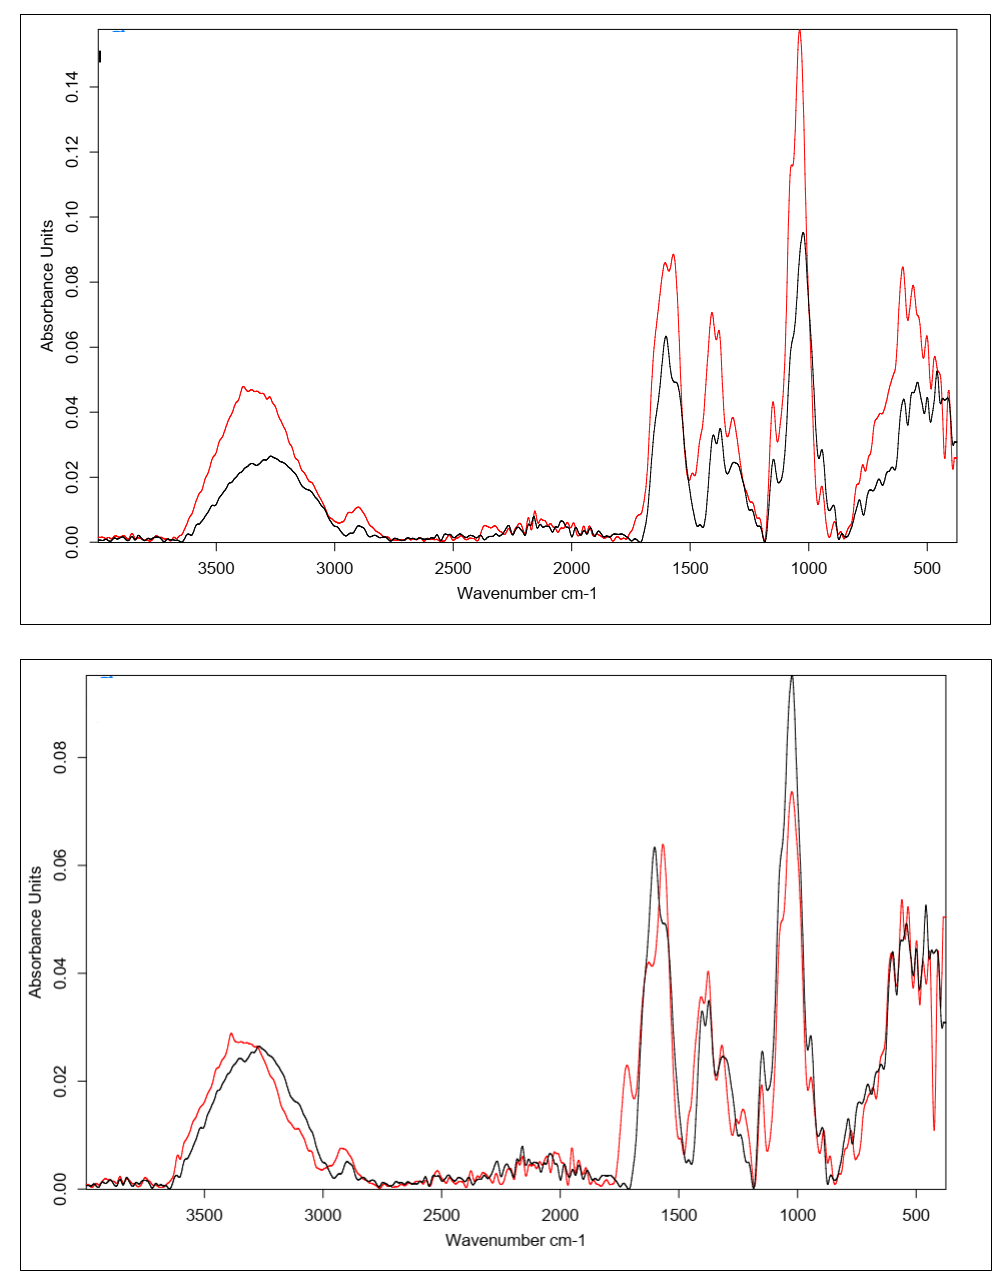
Figure 9. FT-IR spectra of HA cross-linked with CA via Procedure II with different concentrations of the cross-linking agent. FT-IR spectrum of native HA (black) vs. HA cross-linked with citric acid via Procedure II: 5% (top, red) and 20% (bo tt om, red).